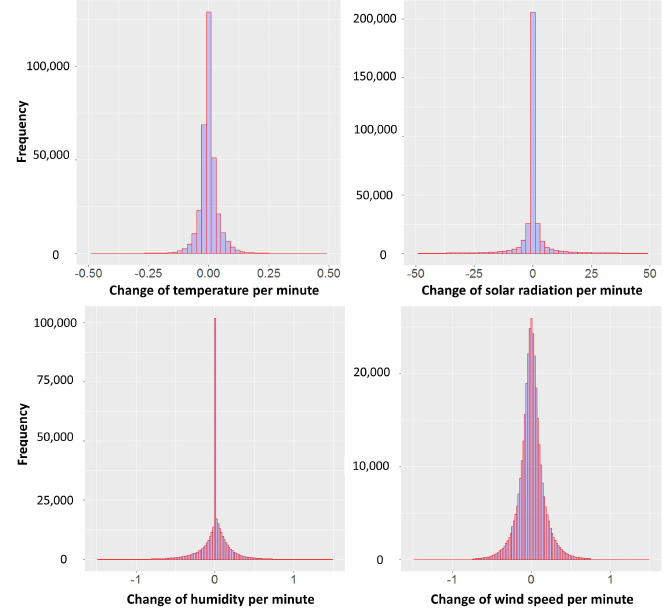
Figure 7. Histogram plot of the change per minute for the attributes solar radiation, temperature, humidity, and wind speed for all the historical data. The absolute value of the changes were used for estimating the